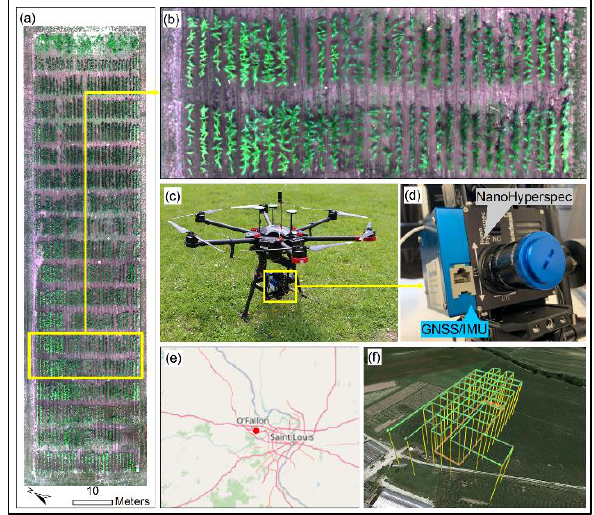
Figure 1. Study area and data collection instruments, (a) a RGB image of the maize field, (b) a close-up view of the field marked with a yellow box in (a), (c) the DJI M600 Pro UAV equipped with sensors, (d) a close up view of the sensor package which includes a Headwall Nano-Hyperspec VNIR camera, A FLIR Vue Pro thermal camera and APX-15 GNSS/IMU unit all attached in a DJI Gimbal, (e) the location of the study area, and (f) the cross-grid flight pattern created in UGCS flight planning software (v4.0.187) which was used for data